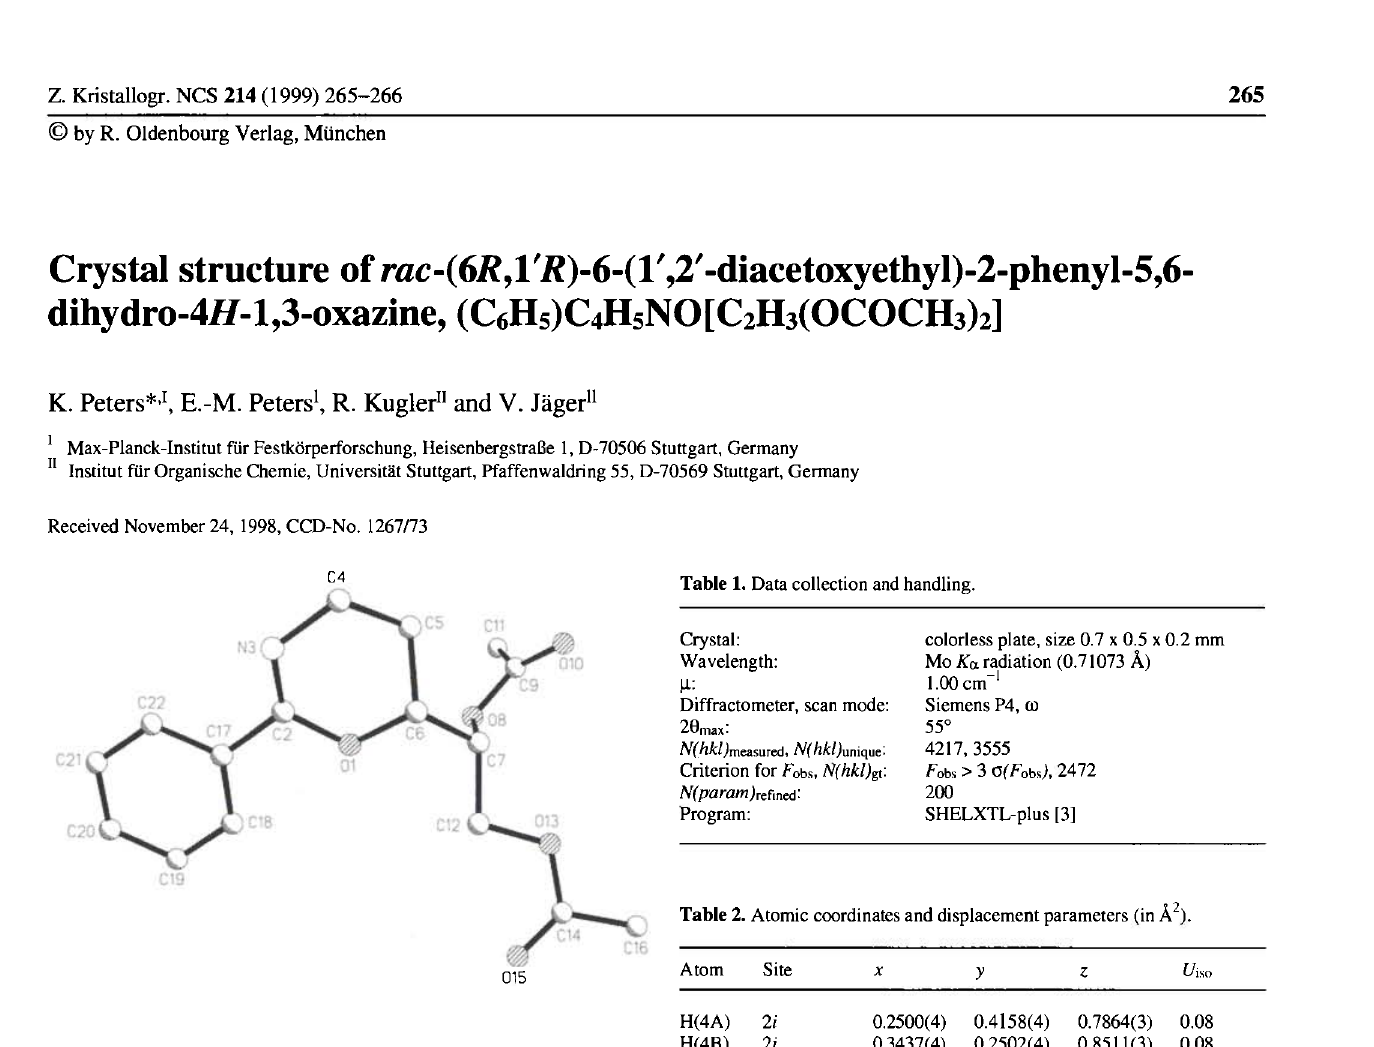
Table 2. Atomic coordinates and displacement parameters (in A 2 ).